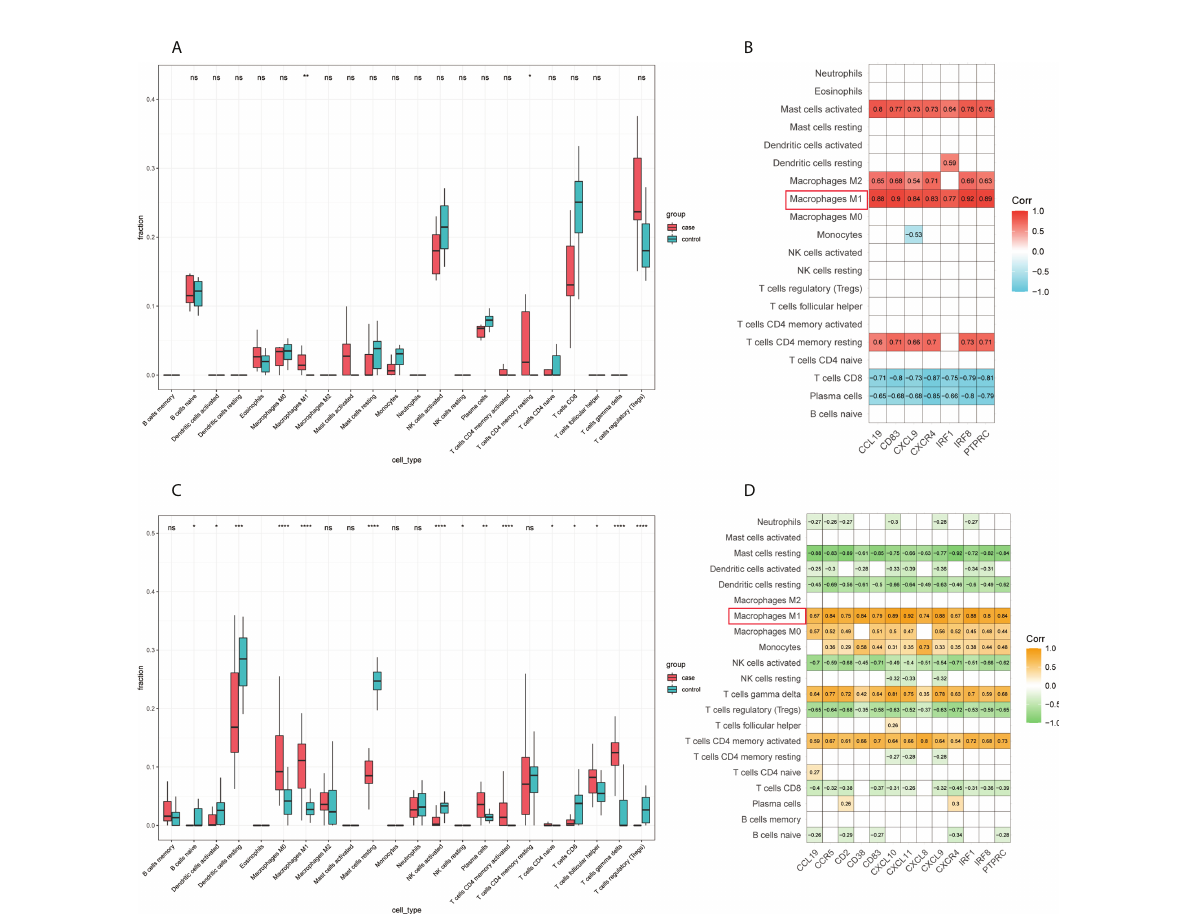
FIGURE 9 In fi ltrating immune cells by CIBERSORT and its correlation with hub genes: (A) fraction of in fi ltrated immune cells in GSE125733, *p < 0.05, **p < 0.01, *** p < 0.001, **** p < 0.0001; (B) correlation heat map between the expression levels of hub genes and immune in fi ltration scores in GSE125733; (C) fraction of in fi ltrated immune cells in GSE65914, *p < 0.05, **p < 0.01, ***p < 0.001, ****p < 0.0001; and (D) correlation heat map between the expression levels of hub genes and immune in fi ltration scores in GSE65914. ns, no signi fi